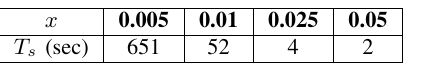
Fig. 5. (cid:4) - values of δ (1) regressions y ( x ) , x = h/a d